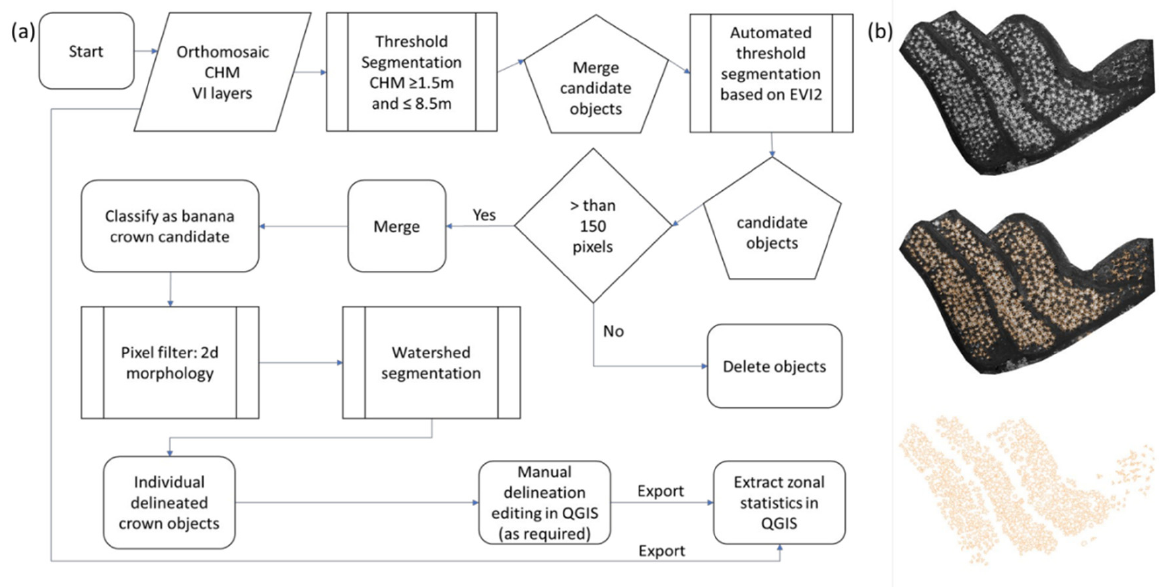
Figure 4. ( a ) Overview of the main components of the crown delineation workflow within the eCognition Developer softwar, and ( b ) example orthomosaic (top) and progression toward individual delineated crown objects (bottom) created using the workflow.